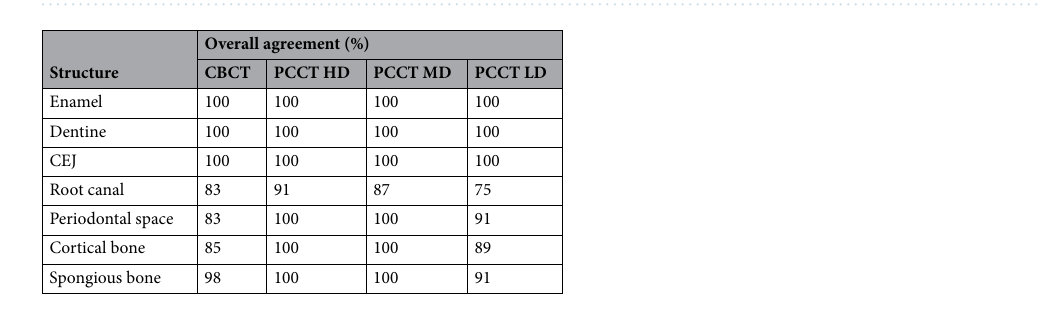
Table 1. Overall interrater agreements of visibility scores.